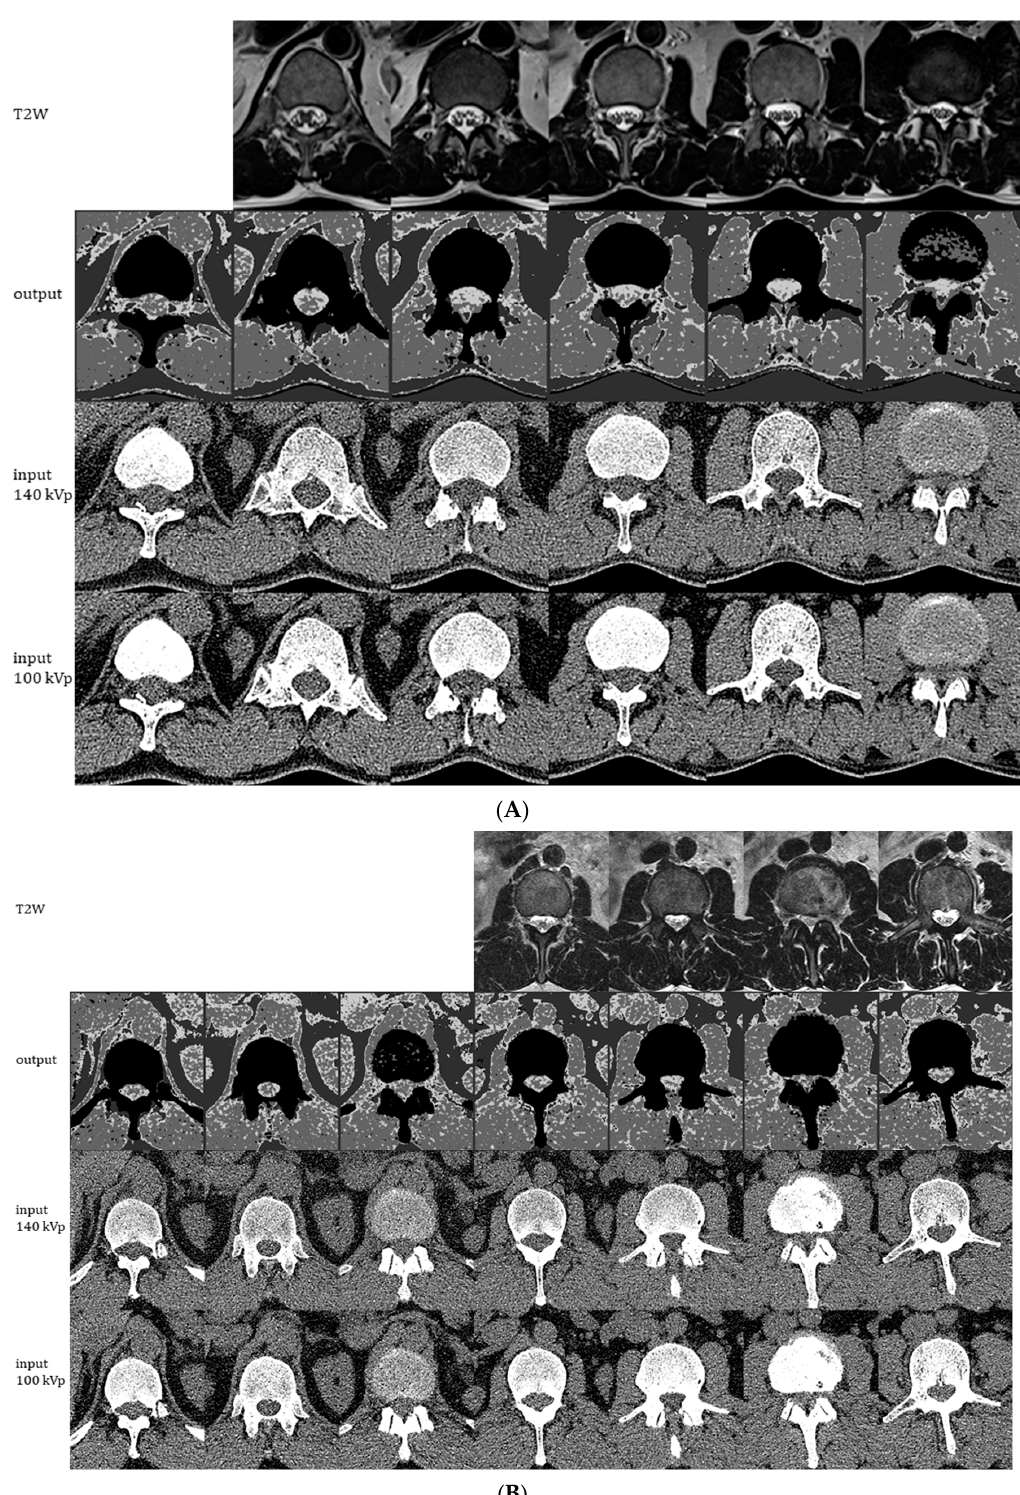
Figure 6. Representative images generated by the ensemble model as applied to 1 of the 11 CT exams used for individual model training/validation ( A ) and to the holdout CT exam that was not used for training ( B ). The montages show generated 4-scale output images (2nd row), original 0.75 mm CT images at 140 kVp (3rd row), and original 0.75 mm CT images at 100 kVp (4th row). Each column of CT images shown represents slices at 2.25 cm intervals. Corresponding 5 mm axial T2W MRI images are shown in the 1st row for